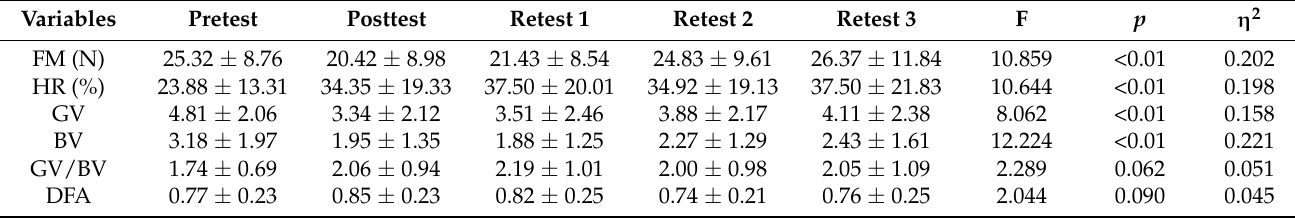
Table 1. Average error values (mean ± SD) in all the tests calculated in the study and repeated measures ANOVA statistics for the effect of training in the experimental variables.